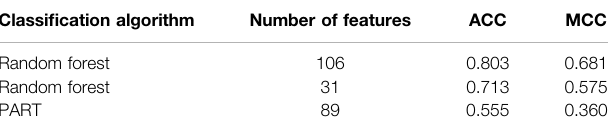
TABLE 3 | Performance of key classi fi ers with different algorithms based on the MCFS feature